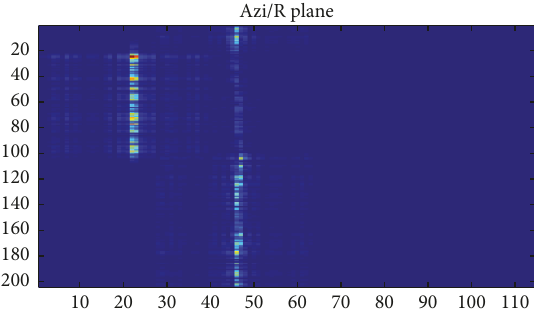
Figure 21: Azimuth-range plane.